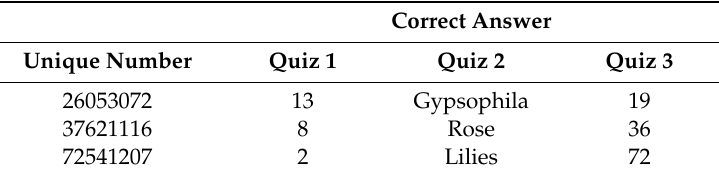
Table 2. Individual, di ff erent correct answers to popup